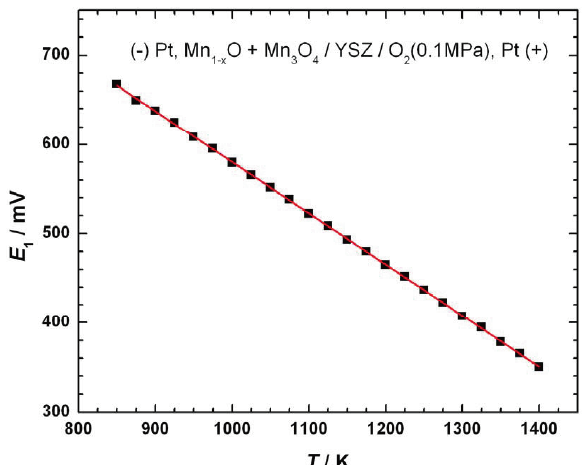
Figure 3. Temperature dependence of the emf of cell 1.